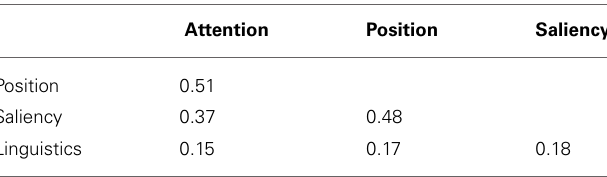
Table 7 | Pairwise correlations (Pearson’s r ) between the composite feature used in the LME